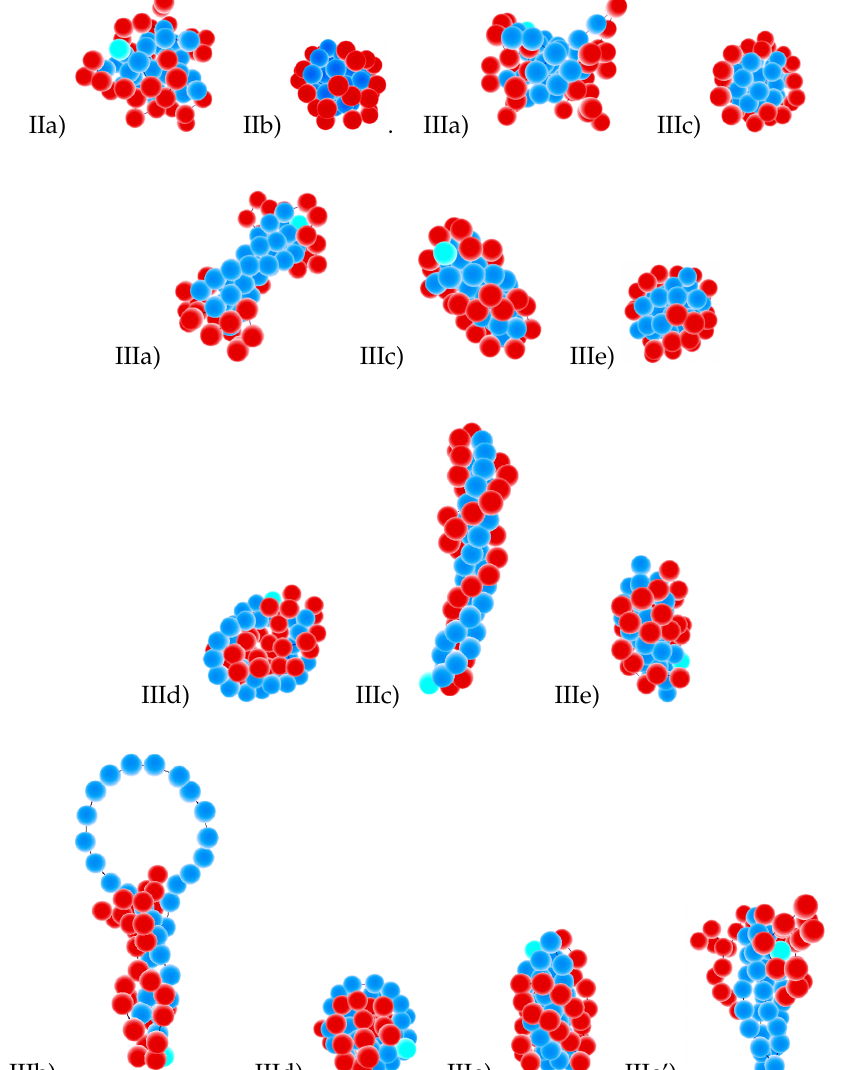
Figure 8. Selected conformations (IIa, IIb, IIIa, IIIb, IIIc, IIId, IIIe, IIIe’ indicated for each snapshot) for the case “S-attract-stronger”, for block lengths b = 4,8,16,32 (in rows from top to bottom). Beads of S-blocks are blue; beads of F-blocks are